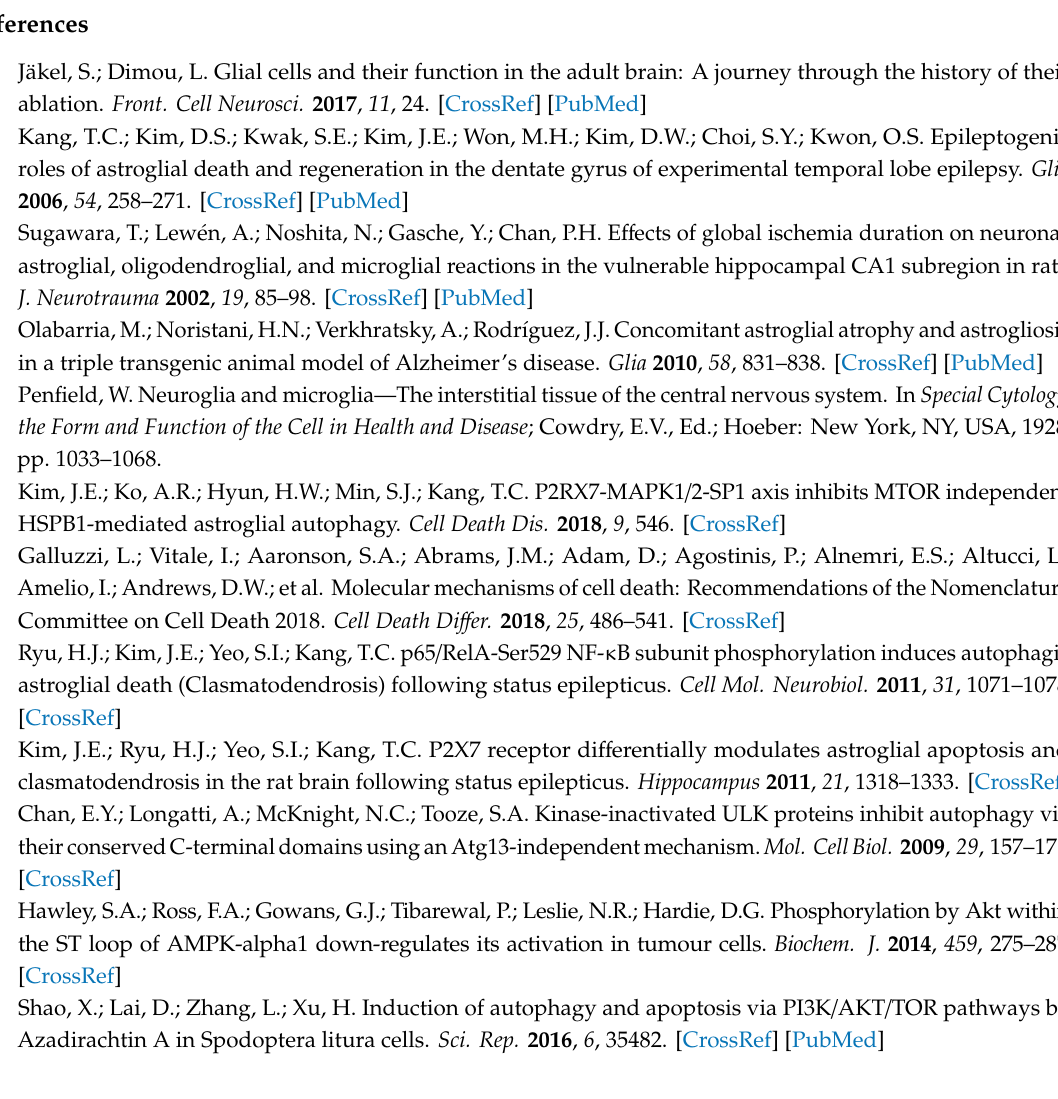
Figure S1: Representative full-gel images of Western blots in Figure S1; Figure S2: Representative full-gel images of Western blots in Figure S2; Figure S3: Representative full-gel images of Western blots in Figure S3; Figure S4: Representative full-gel images of Western blots in Figure S4; Figure S5: Representative full-gel images of Western blots in Figure S5; Figure S6: Representative full-gel images of Western blots in Figure S6; Figure S7: Representative full-gel images of Western blots in Figure S7; Figure S8: Representative full-gel images of Western blots in Figure S8; Figure S9: Representative full-gel images of Western blots in Figure 9A; and Figure S10: Representative full-gel images of Western blots in Figure 9C. Supplementary Table S1: Primary antibodies used in the present